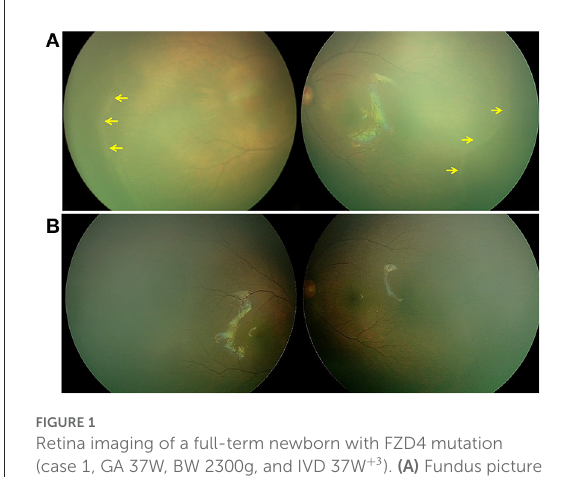
FIGURE1 Retina imaging of a full-term newborn with FZD4 mutation (case 1, GA 37W, BW 2300g, and IVD 37W + 3 ). (A) Fundus picture showing retinal ridges (yellow arrow) in zone II in bilateral eyes and avascular retinal periphery. (B) Fundus images of both eyes showing that the ridge resolved spontaneously 26 months after the first